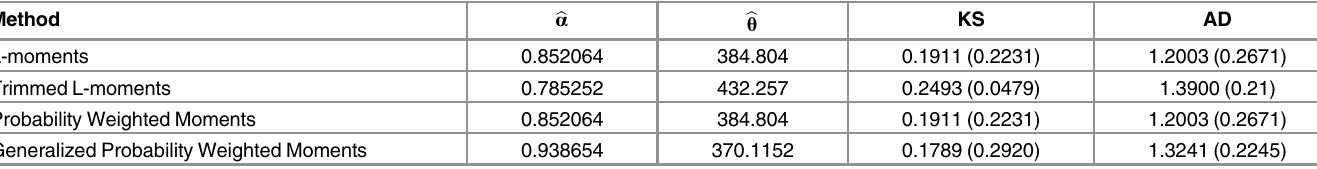
Table 5. Kolmogorov-Smirnov (KS) and Anderson-Darling (AD) test on real data set.